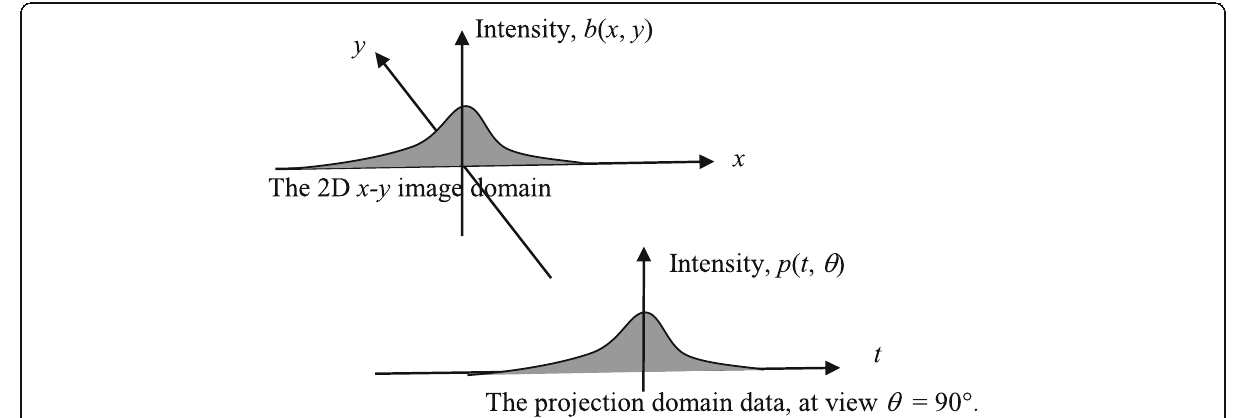
Fig. 2 The time-of-flight (TOF) backprojector is equivalent to a backprojector, in which the projection (here, the TOF profile function) is first rotated by 90° and then is backprojected only to the line passing through the origin and parallel to the